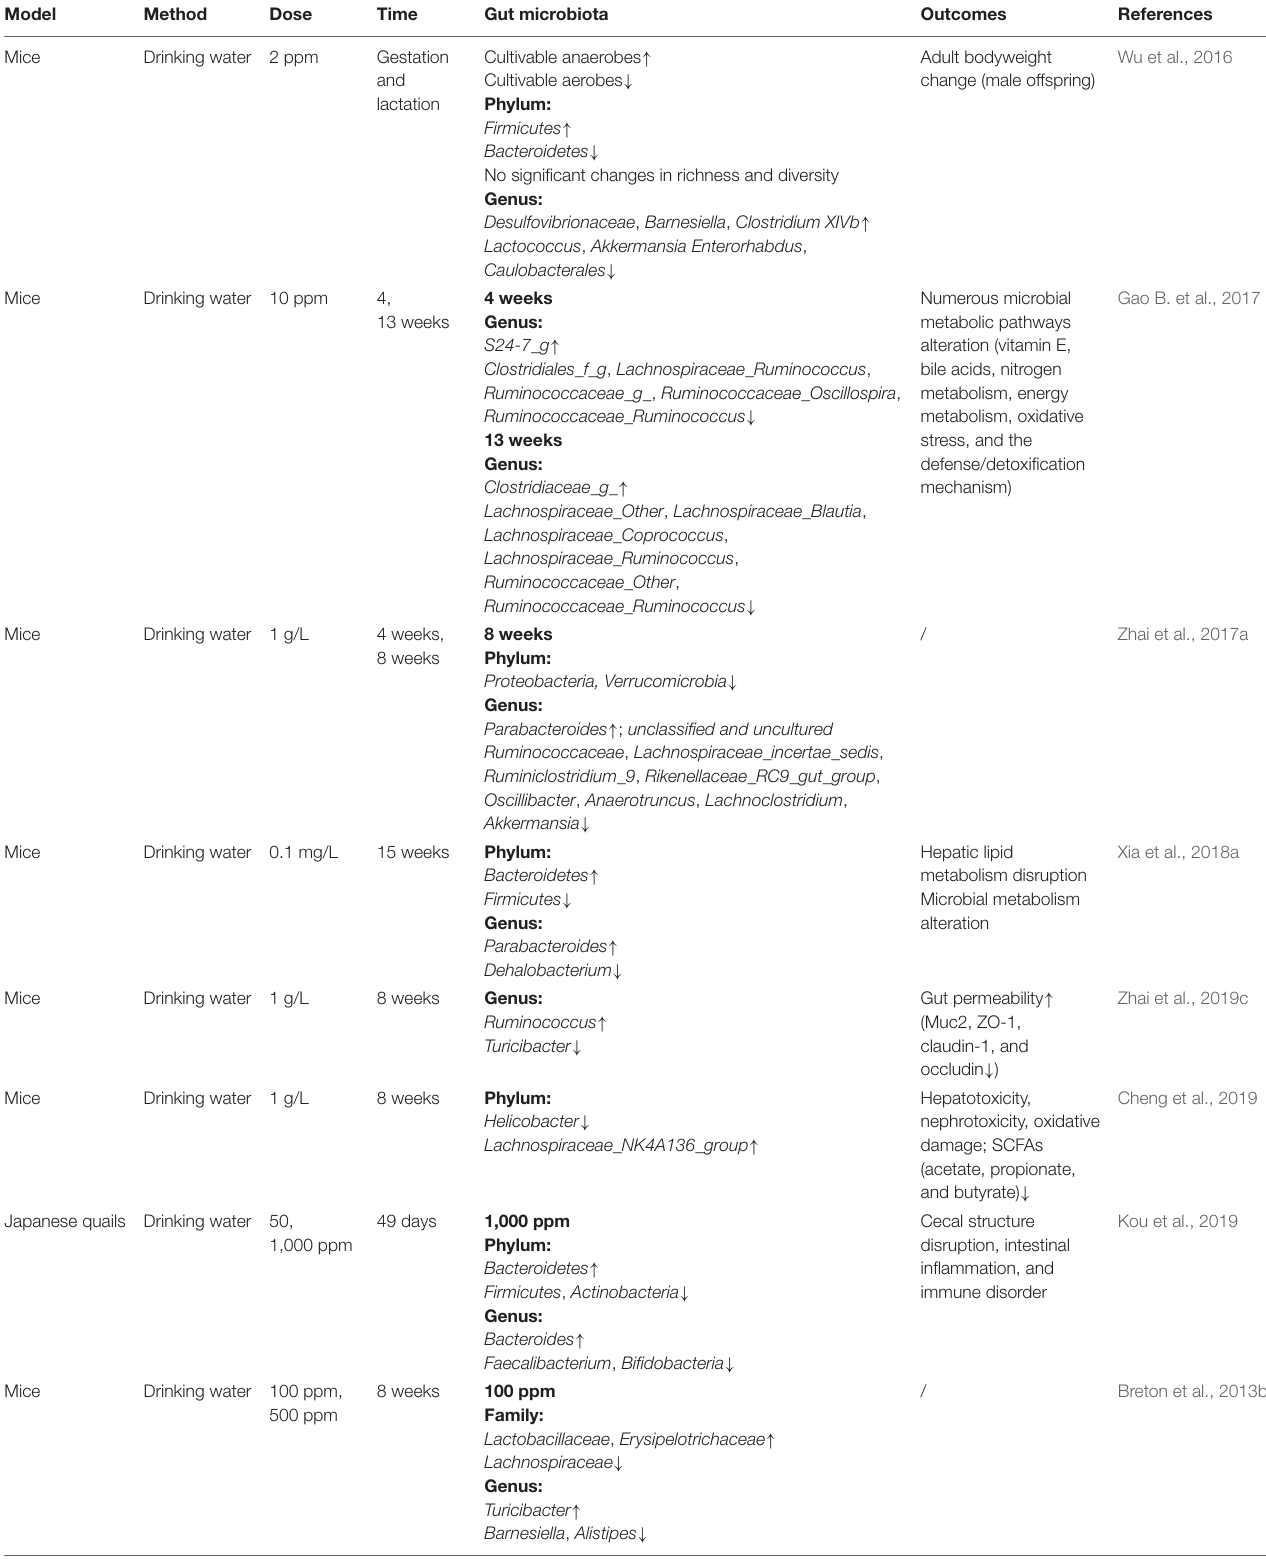
TABLE 1 | Effects of Pb on gut microbiome and